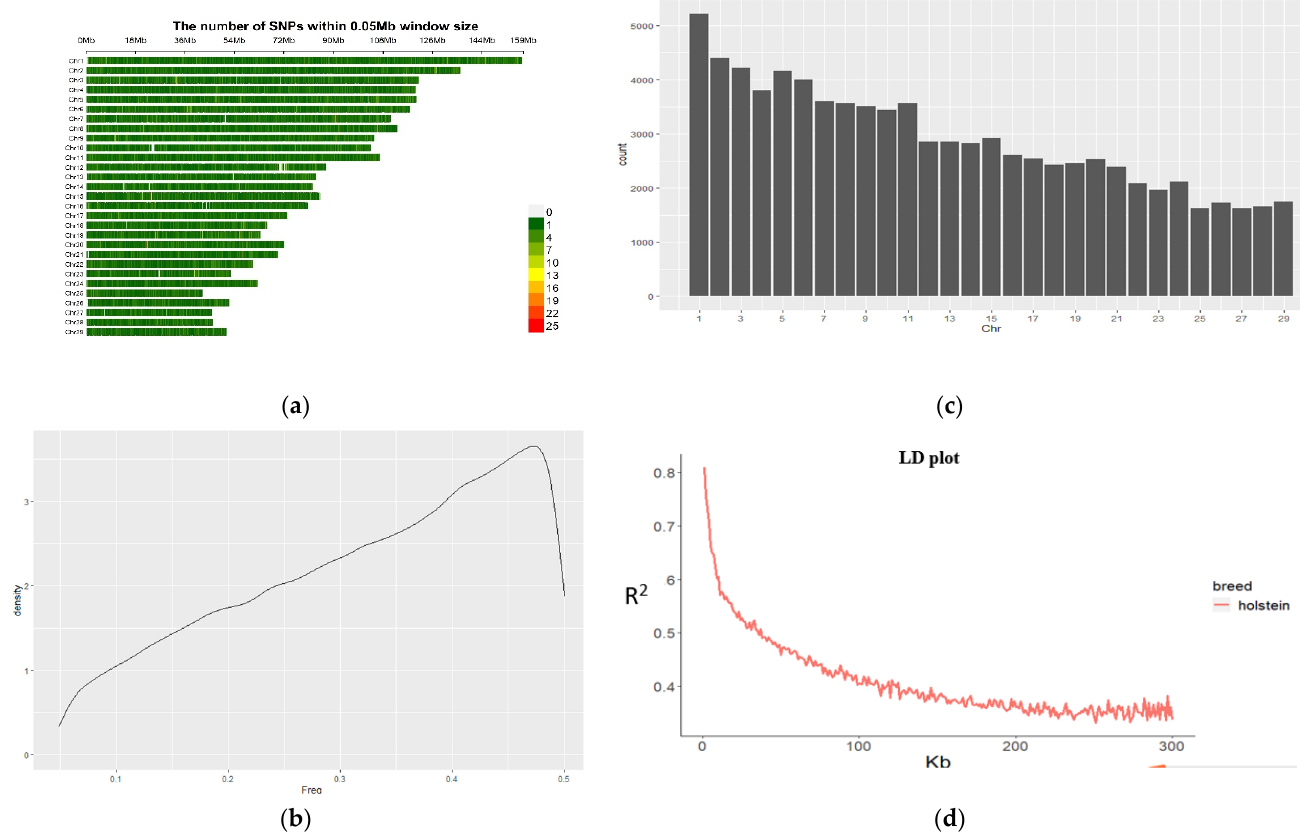
Figure 1. Properties of single nucleotide polymorphisms (SNPs). In total, 1000 individuals were genotyped by the GeneSeek Genomic Profiler Bovine 100 k bead chip; 84,609 SNPs and 984 cattle passed filters and quality control. Marker distributions are displayed in a heatmap on 29 chromosomes by minor allele frequency (MAF) ( a ). MAF was re-calculated after quality control. Therefore, some SNPs remained with MAFs lartherthan 0.05, as shown by the histogram ( b ). Marker density is displayed by the histogram on chromosome 29 ( c ). LD decay is shown by scatter plot according to pairwise distance and trend as a red line ( d ).